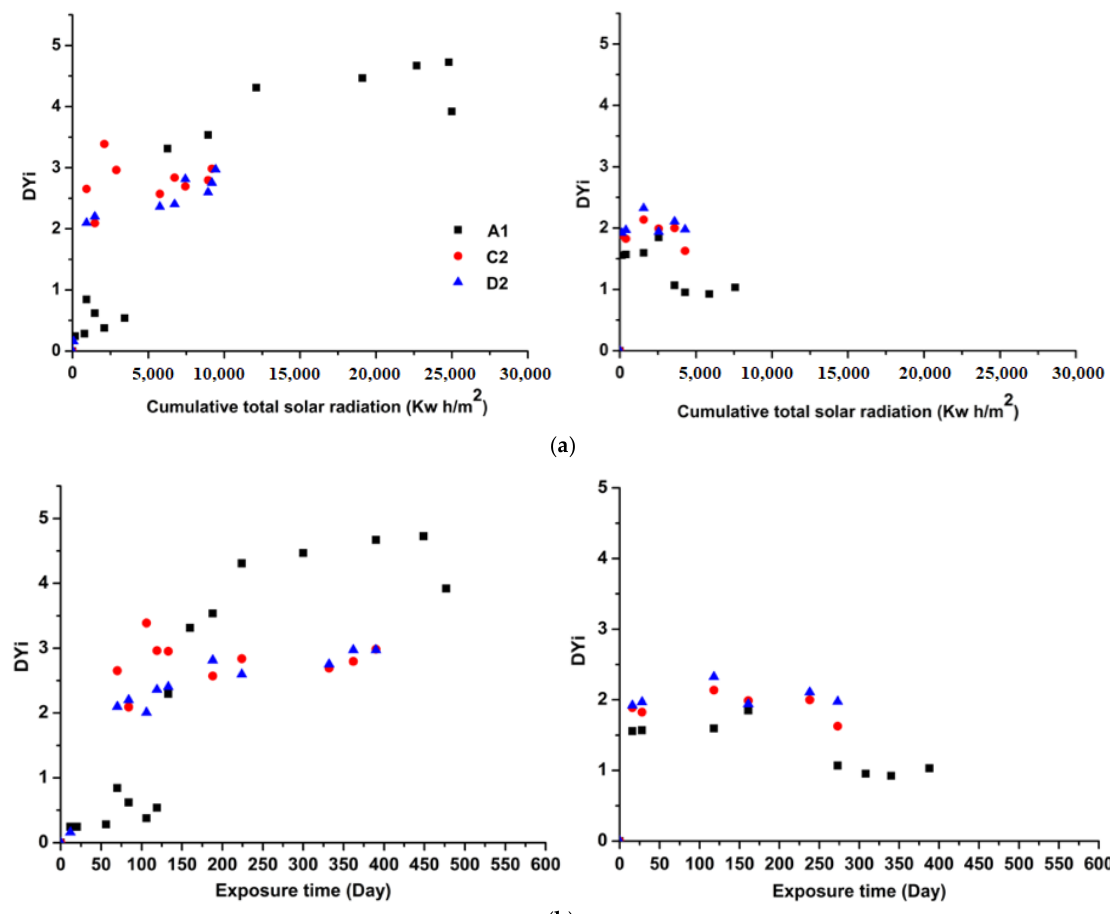
Figure 10. Evolution of yellowing parameter (ΔYi) in function of ( a ) cumulative solar radiation and ( b ) exposure time of monolithic mirrors (A1, C2 and D2) paint coatings exposed at the seaside site ( left ) and the desert site ( right ).